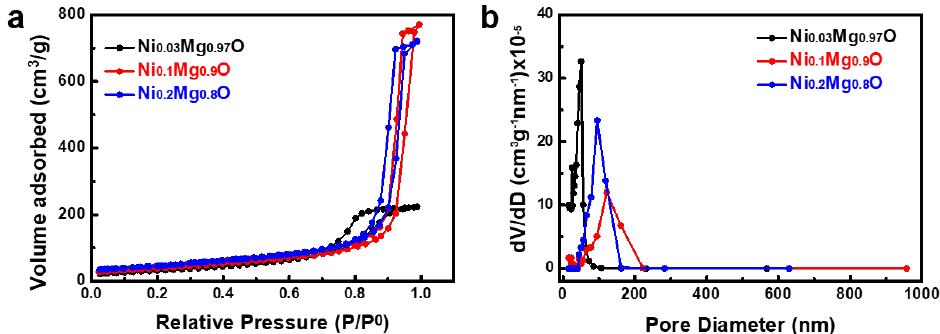
Figure 3. ( a ) N 2 adsorption / desorption isotherms of Ni x Mg 1-x O catalysts, ( b ) pore size distributions of Figure 3. (a) N 2 adsorption/desorption isotherms of Ni x Mg 1-x O catalysts, (b) pore size distributions of 113 Ni x Mg 1 − x O Ni x Mg 1−x O catalysts. 114